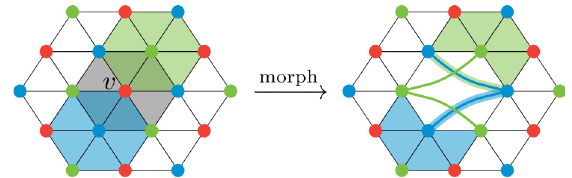
FIG. 4. Morphing a ball-like region of a 2D color code. Qubits are on triangles and stabilizers are associated with vertices. On the left, we shade the ball-like region B v , which has an associated [[6,4,2]] ball code. We also shade the support of an X -type and Z -type stabilizer in blue and green, respectively. On the right, we show the new lattice formed by morphing B v , replacing the original qubits with the four logical qubits of the ball code (blue and green edges). This changes the support of the highlighted stabilizers, as shown.